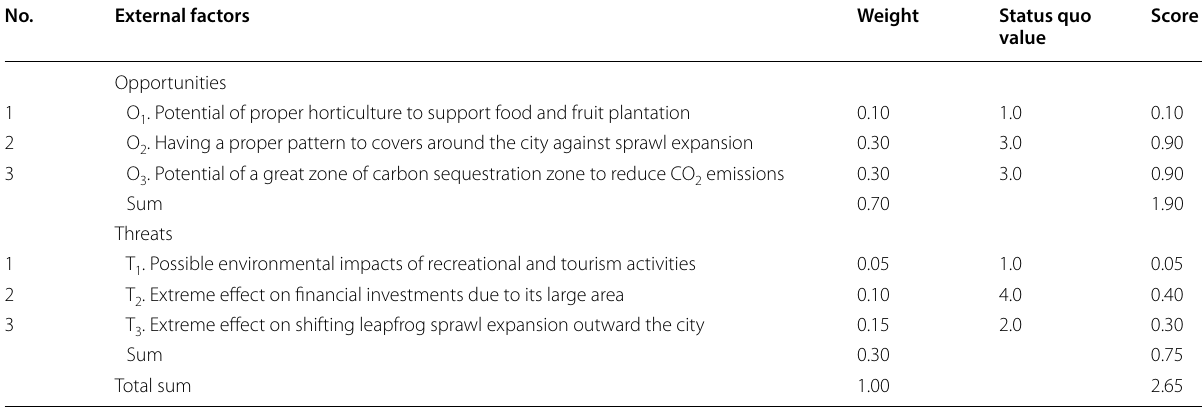
Table 9 External factor’s matrix for opportunities and threats